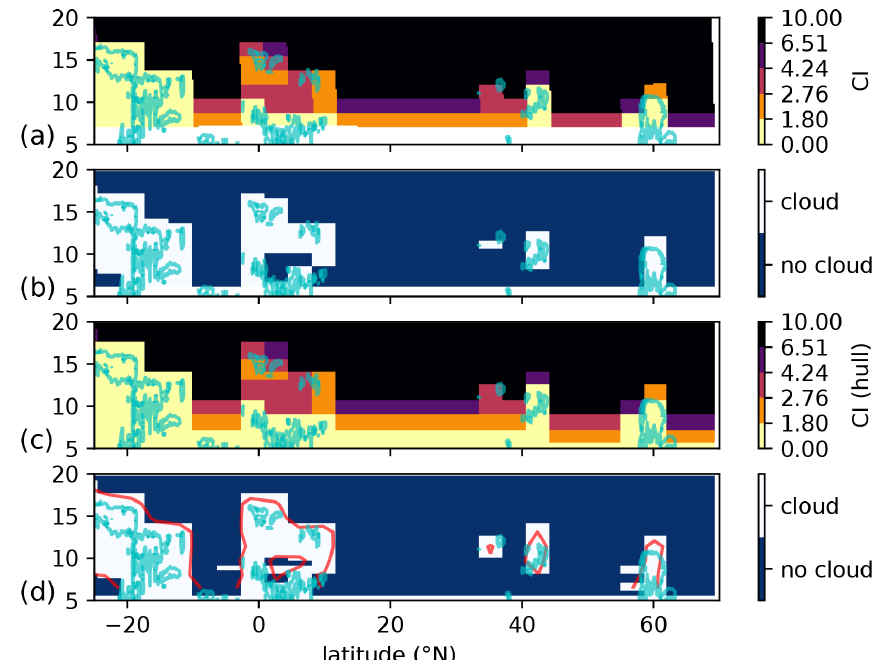
Figure 3. Result of the convex hull CI algorithm for MIPAS simulations based on CALIOP extinctions reduced by a factor of 10. Panel (a) shows the CI at the location of tangent points. Panel (b) shows the location of clouds according to the altitude dependent CI threshold. Panel (c) shows the CI determined with the convex hull CI algorithm. Panel (d) shows the location of clouds according to the altitude- dependent CI threshold. The cloud position from (b) is shown as a red contour line for reference. The contour line for a “true” extinction value of 10 − 3 km − 1 is shown as a light blue line in all panels. The satellite looks northwards in these